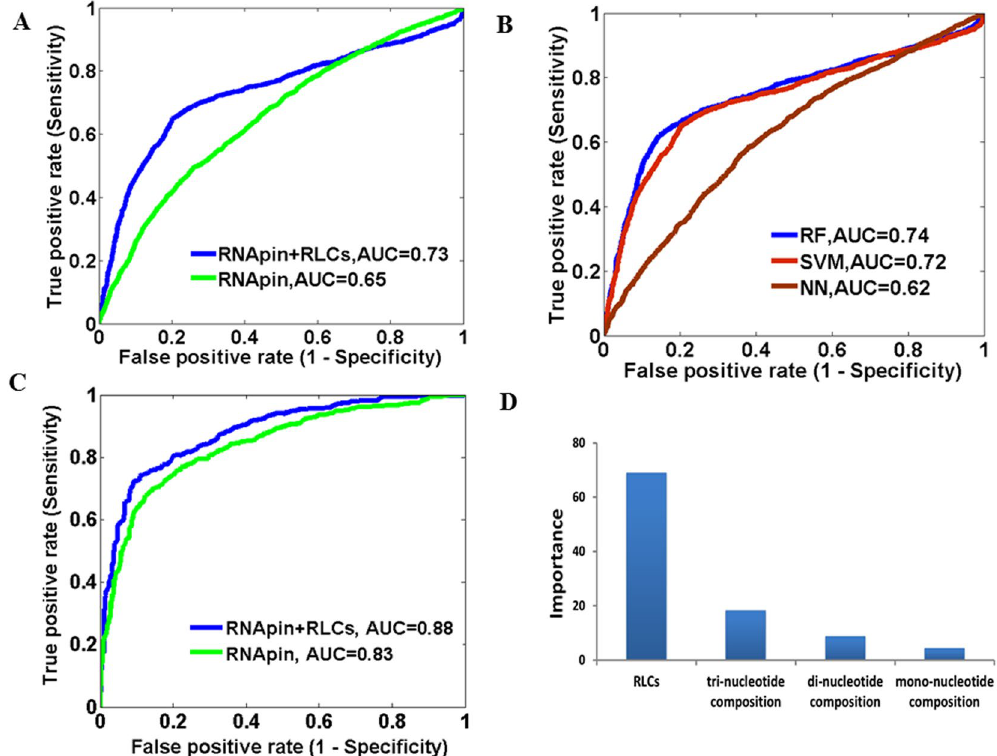
Figure 6. The performance of protein binding site prediction. ( A ) Comparison of ROC curves for binding site prediction using different features on our constructed database. ( B ) Comparison of ROC curves for binding site prediction using different classifiers. ( C ) Comparison of ROC curves for binding site prediction on an independent dataset. ( D ) The importance and individual contribution ratio of each feature